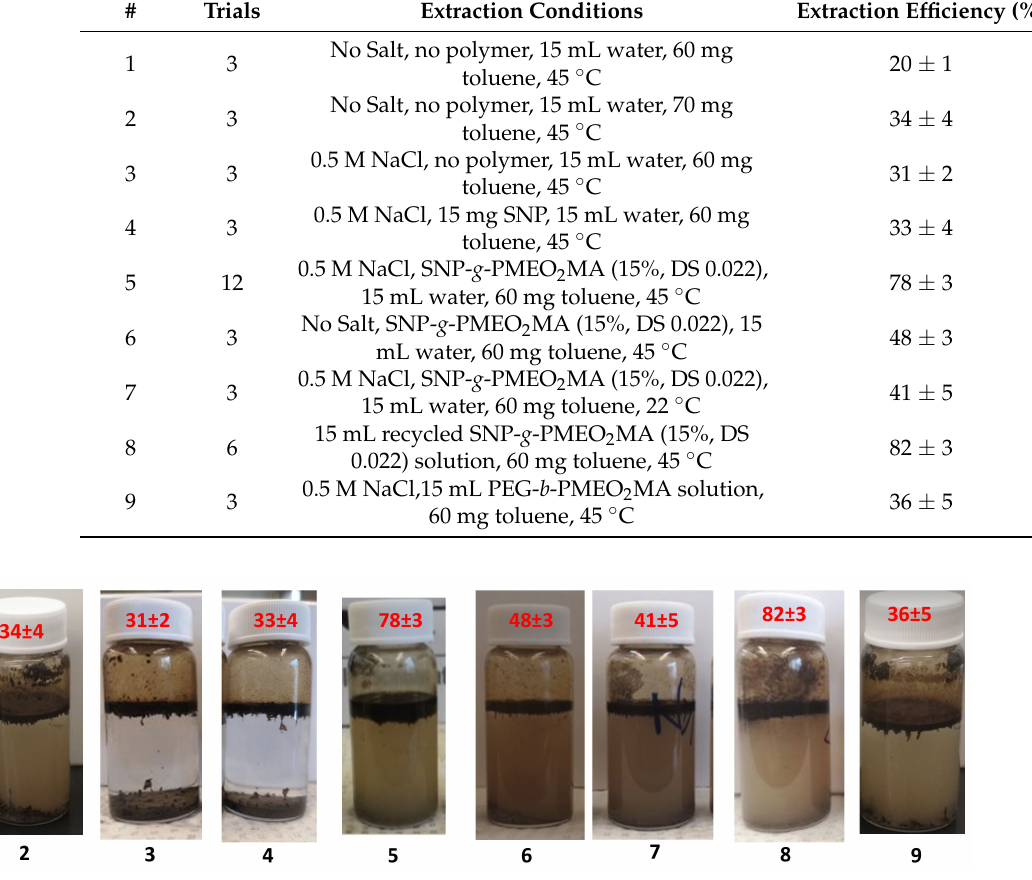
Figure 9. Appearance of bitumen extractions corresponding to Table 3 after 24 h